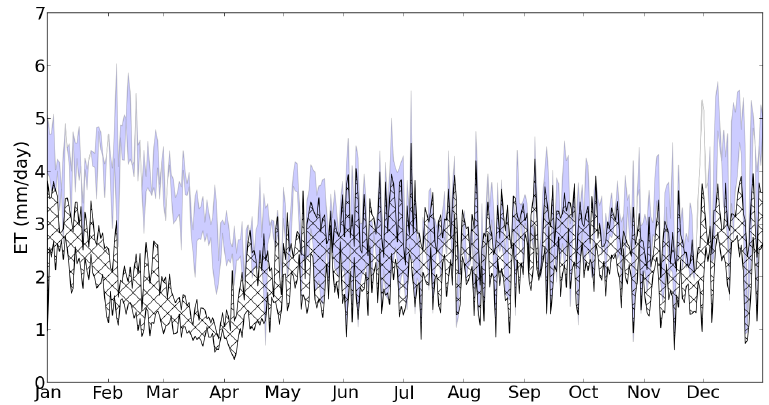
Figure 9. Variability of daily ET as measured at the flux towers (light blue area) and simulated (shaded area) at Sardinilla plantation, Panama